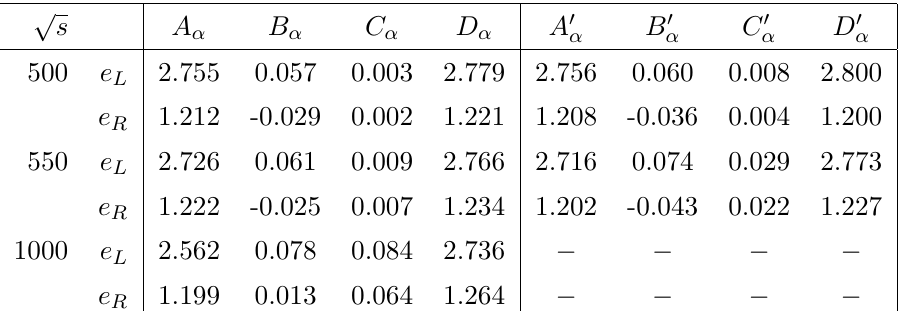
Table 4 . e + e (cid:0) ht (cid:22) t cross sections at LO, with NLO and Coulomb-resummation corrections for ! the pure scalar and pseudoscalar processes at p s = 500 GeV, 550 GeV, and 1000 GeV.